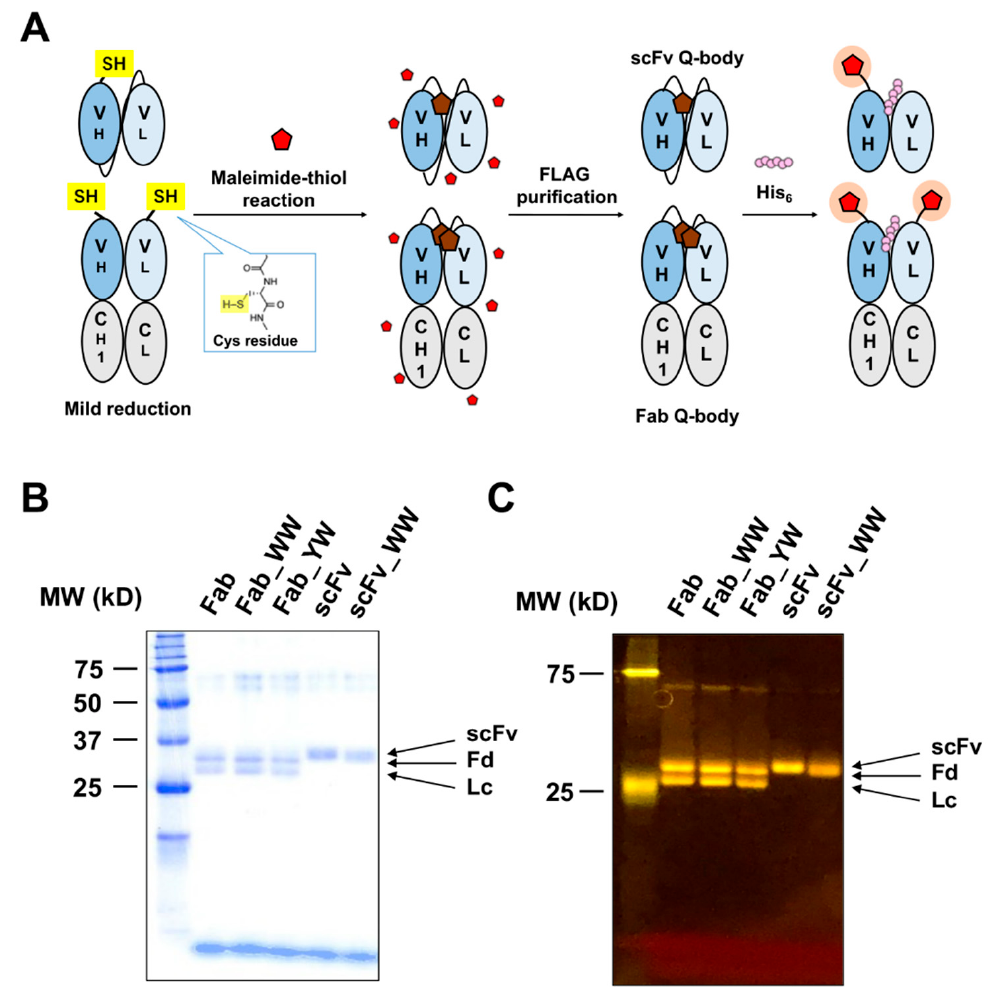
Figure 2. Construction of scFv/Fab Q-bodies labeled with maleimide dye at the N-terminus. ( A ) Scheme for the construction of scFv- and Fab-type Q-bodies labeled with maleimide dye at the N-terminus of H chain in scFv, and at both heavy (Fd = V H -C H 1) and light (Lc = V L -C L ) chains in the Fab. ( B ) Coomassie Brilliant Blue (CBB)-stained and ( C ) fluorescence images of 5-TAMRA (tetramethylrhodamine) C6 maleimide-labeled wild-type scFv/Fab Q-body and their variants.